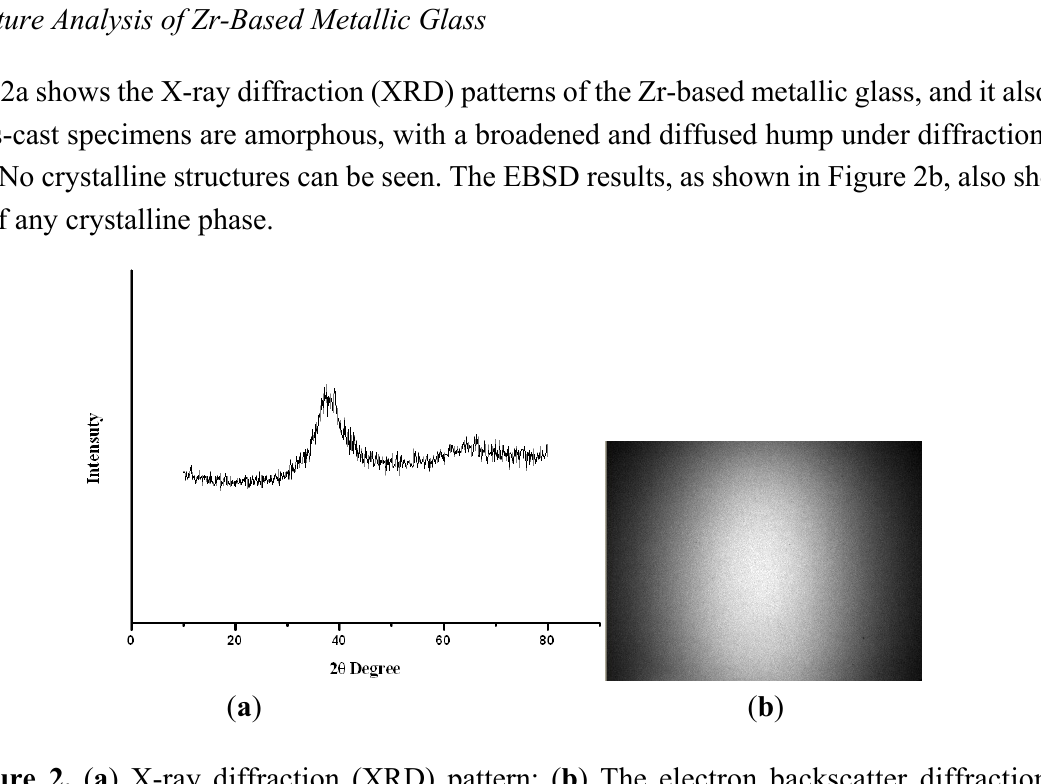
Figure 2. ( a ) X-ray diffraction (XRD) pattern; ( b ) The electron backscatter diffraction (EBSD pattern of the as-cast Zr-based metallic